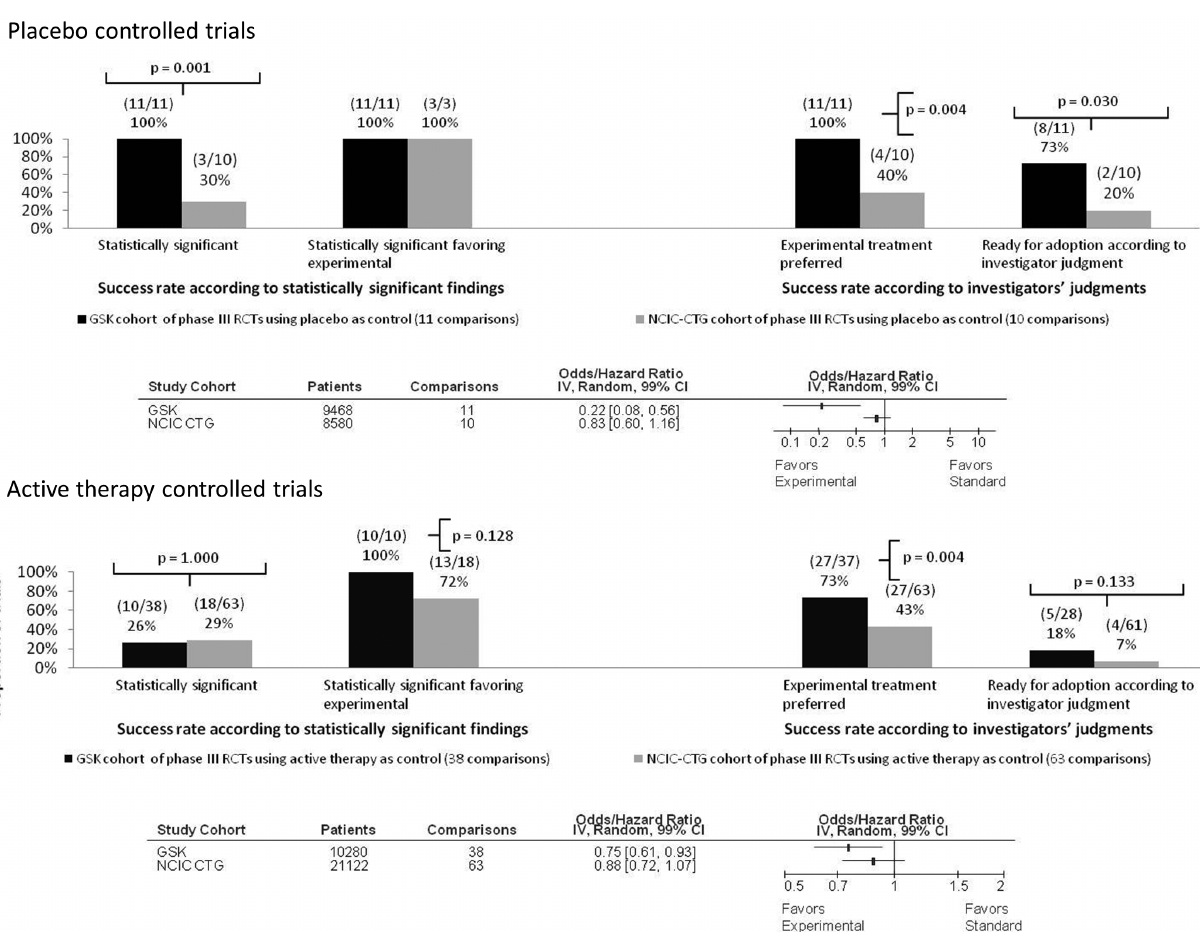
Figure 9. Comparison according to placebo versus active comparator. (A) Success rate according to statistically significant findings, investigator judgment and meta-analysis in placebo controlled trials. (B) Success rate according to statistically significant findings, investigator judgment and meta-analysis in trials having active treatment as control. Statistically significant results were observed in GlaxoSmithKline (GSK) trials according to all 3 metrics of summarizing treatment success (a proportion of statistically significant results favouring experimental treatment, according to the investigators’ judgments and quantitative pooling of data). (B). When the active comparator was used, this was only true for the metrics according to investigators’ judgments. Test of interactions in placebo-controlled trials was highly significant in favour of GSK compared to National Cancer Institute Canada Clinical Trials Group (CTG) comparisons (p=0.001) while it was not significant (p=0.154) between trials when active control was used as a comparator.